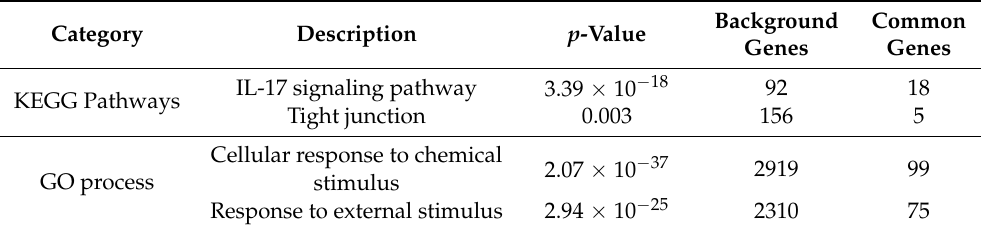
Table 2. AEO target pathway based on KEGG 2021 human pathway and GO